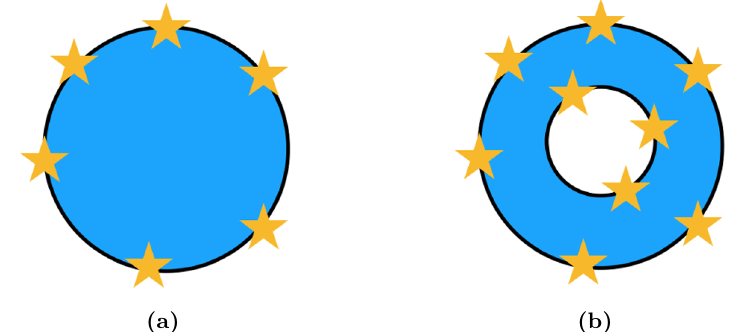
Figure 3. Leading (a) and subleading (b) diagrams in the large N limit. Blue represents arbitrary gluon loops and stars are insertions of M